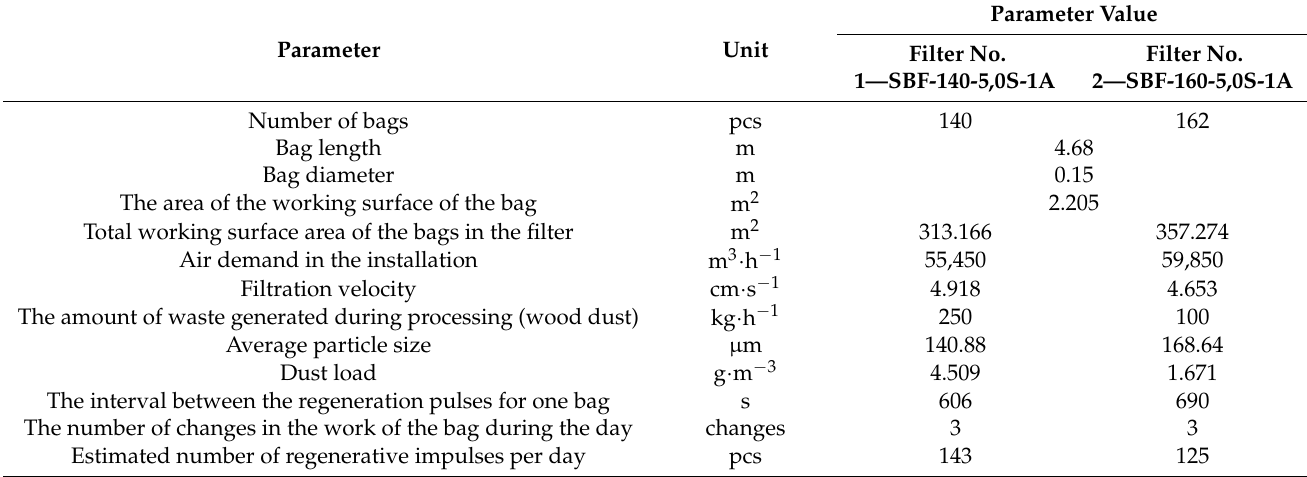
Table 2. Basic technical parameters of the filter baghouses.